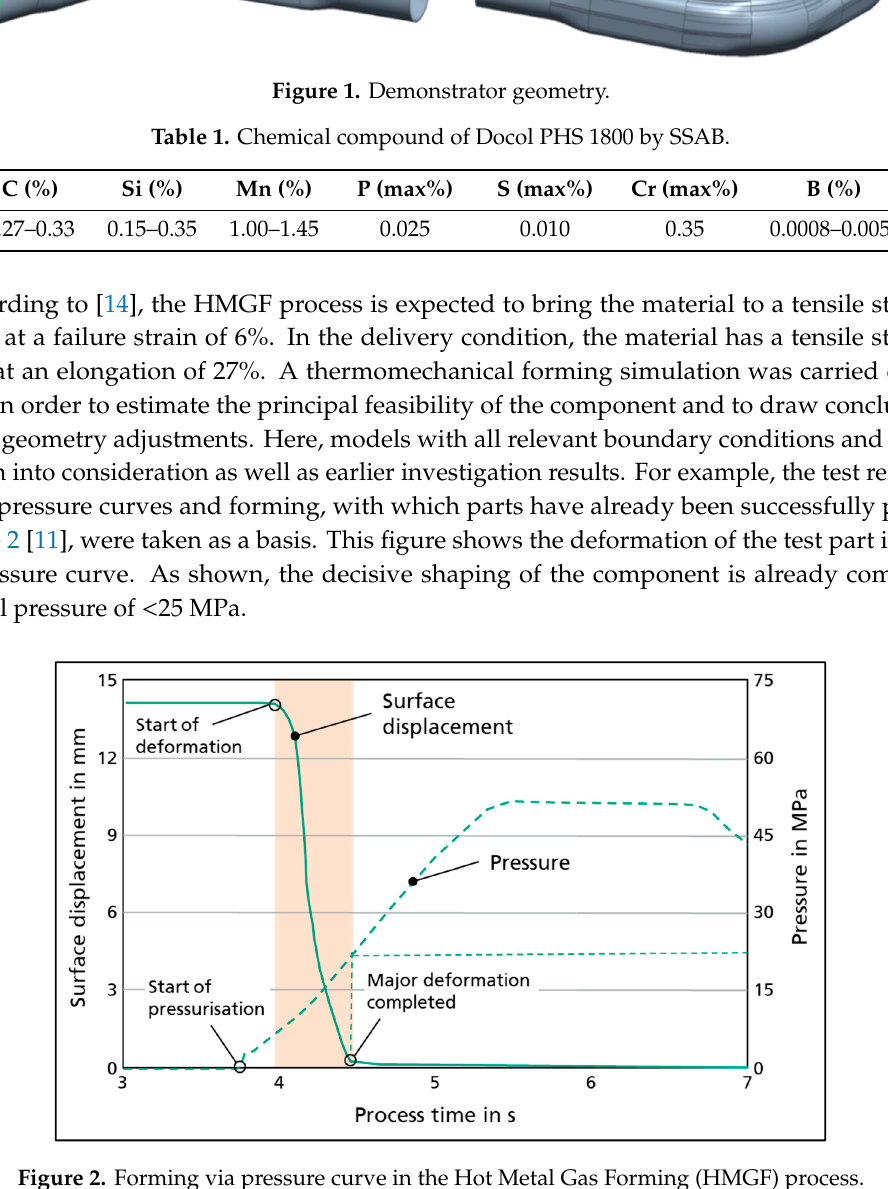
Figure 2. Forming via pressure curve in the Hot Metal Gas Forming (HMGF) process.